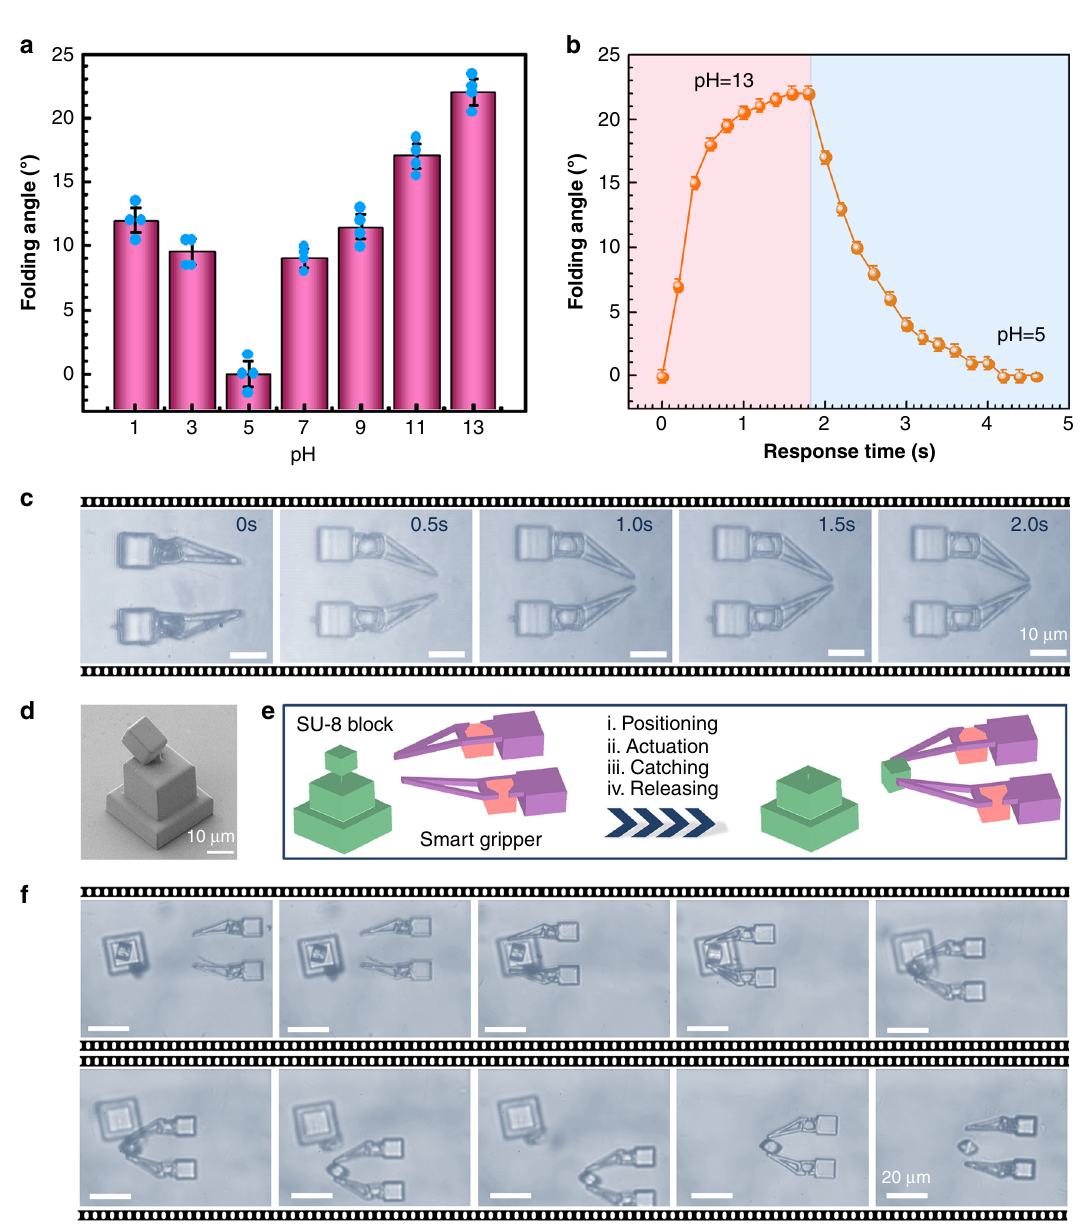
Fig. 5 Flexible manipulation of the smart micro-gripper. a The folding angle of the micro-grippers at different pH values. b The pH-responsive folding dynamics of the micro-grippers. c The actuation process of the micro-gripper in an aqueous solution with pH = 13. d SEM image of the target cargo, a SU-8 block attached to a base. e Schematic procedure of the catching and releasing of the SU-8 cargo using the pH-responsive micro-gripper. f The real process of the manipulation: (i) positioning, the micro-gripper that is integrated with a glass cantilever gradually approached the target and precisely aligned with it with the help of a 3D moving stage; (ii) actuation, the micro-gripper was stimulated by the solution with pH = 13, which triggered the folding of the micro- gripper. In this way, the target block was tightly gripped; (iii) transporting, the micro-gripper holding the object can be transferred to any desired location under the precise control of the motion system; (iv) releasing, the micro-gripper was stimulated by a solution of pH 5, which caused the unfolding of the arms, thus allowing the release of the object. Error bars denote the standard deviation of the measurements. Source data are provided as a Source data fi